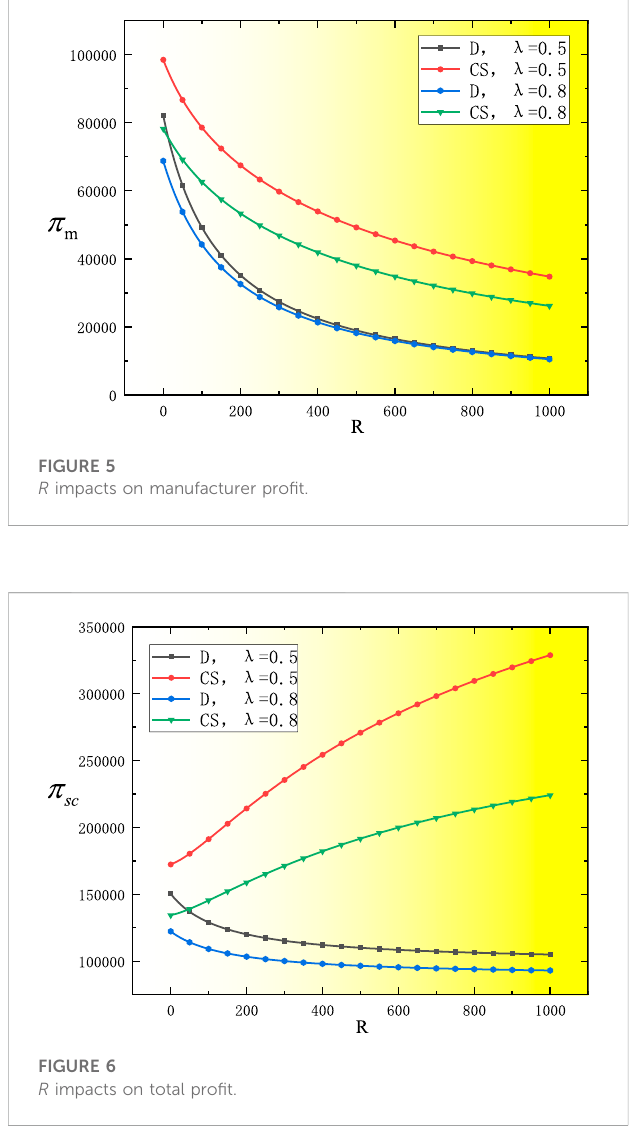
Figure 2, 3 show that under decentralized decision-making and cost-sharing contracts, product greenness and retail price at λ (cid:2) 0 . 5 are both higher than product greenness and retail price at λ (cid:2) 0 . 8.